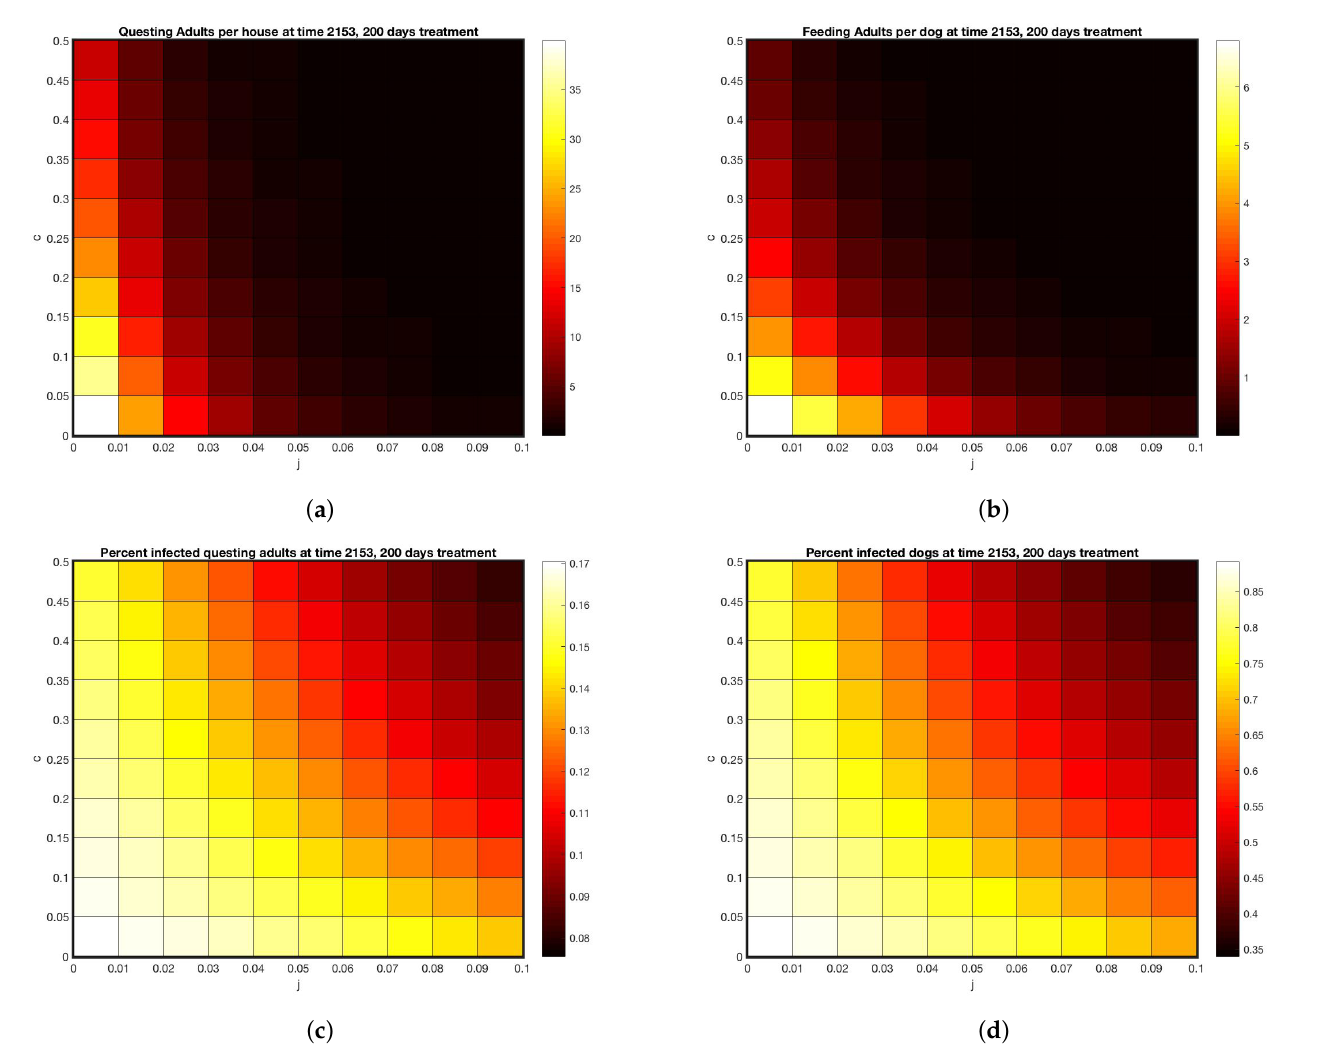
Figure 5. Model predictions under various treatment intensities or coverages for 200 days. ( a ) Abun- dance of questing adults per house ( b ) Feeding adults per dog ( c ) Percent of questing adults infected ( d ) percent of dogs